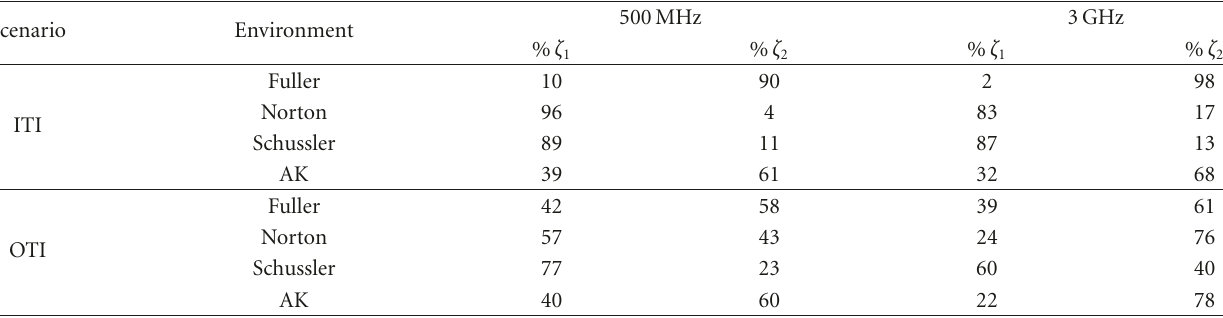
Table 2: Probability of ζ 1 and ζ 2 in NLOS environments.